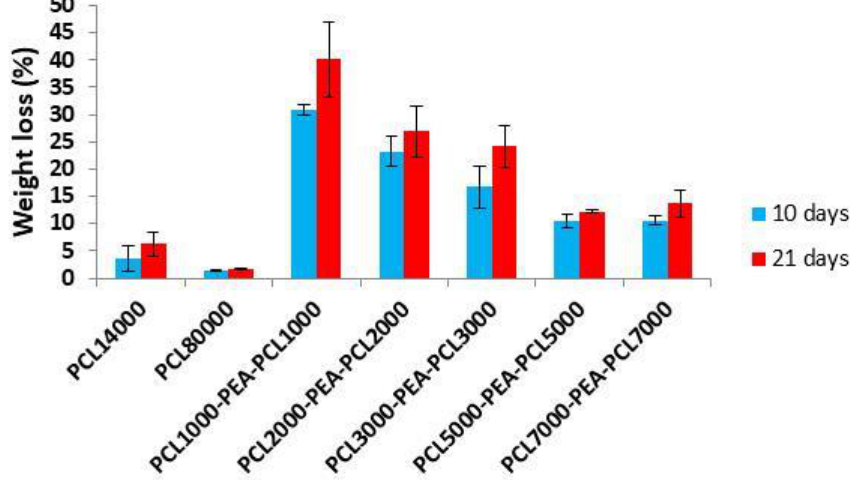
Figure 8. Weight loss profiles of PCL homopolymers and PCL-b-PEA-b-PCL copolymers. FTIR Analysis of Degraded